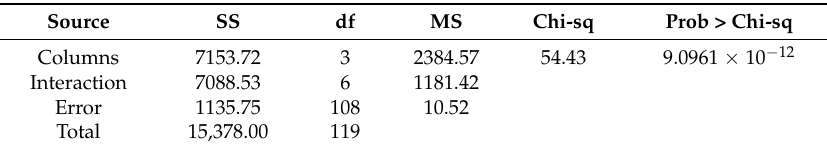
Table 10. Friedman test table for the sensitivity metric.